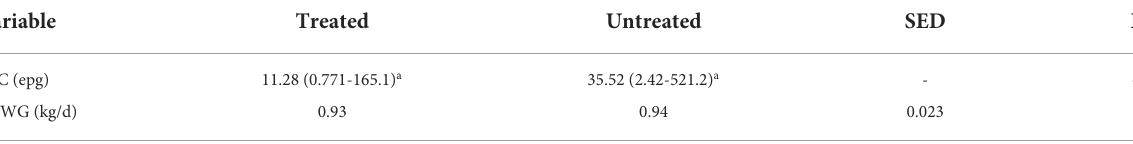
TABLE 5 Daily live weight gain and fecal egg count of treated and untreated groups on S1 and S2. Variable Treated Untreated SED Prob.